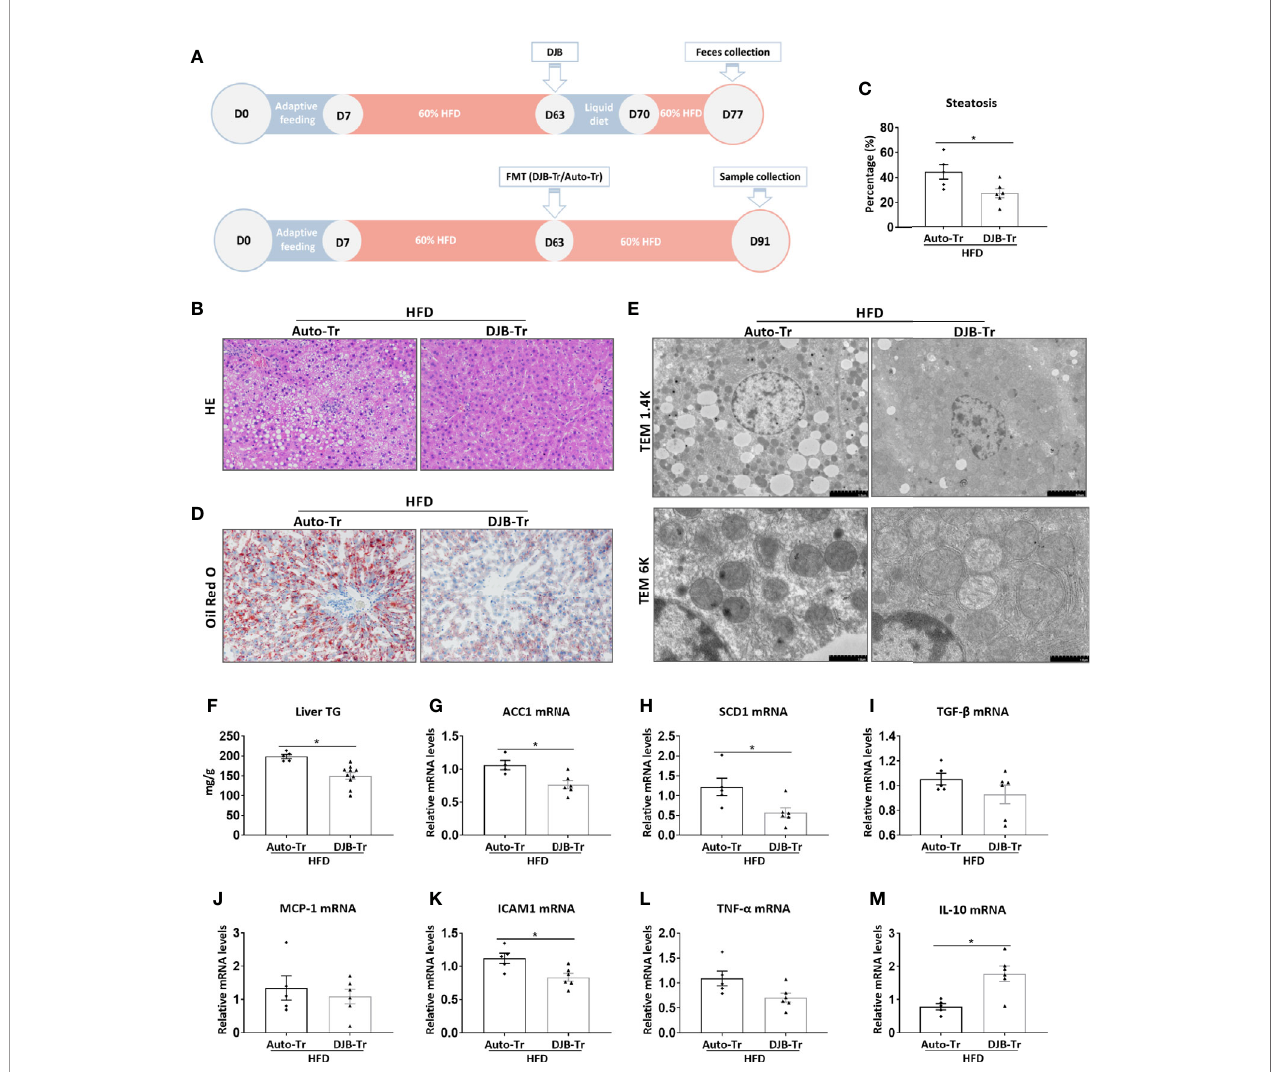
FIGURE 4 | Effects of FMT on hepatic steatosis in HFD-fed rats. (A) Feces were collected from HFD-DJB rats at 2 weeks after surgery. These feces were then transplanted to HFD-fed rats without DJB at 8 weeks after HFD feeding (HFD-DJB-Tr). The control rats received transplantation of their own feces (HFD-Auto-Tr). After fecal transplantation, the animals were maintained on the HFD for 4 more weeks. (B) Representative photomicrographs of liver histology from an HFD-fed rat receiving DJB FMT (HFD-DJB-Tr) and an HFD-fed rat receiving auto FMT (HFD-Auto-Tr). Original magni fi cation, x200. (C) the percentage of steatotic hepatocytes in HFD-DJB-Tr and HFD-Auto-Tr rats. Original magni fi cation, x200. (D) Representative photomicrographs of Oil Red O staining from aHFD-DJB-Tr rat and a HFD-Auto- Tr rat. Original magni fi cation, x200. (E) Representative images of electron microscopy from an HFD-DJB-Tr rat and an HFD-Auto-Tr rat. (F) Liver triglyceride content in HFD-DJB-Tr and HFD-Auto-Tr rats. Hepatic mRNA expression of ACC1 (G) , SCD1 (H) , TGF ‐ b (I) , MCP-1 (J) , ICAM1 (K) , TNF- a (L) , and IL-10 (M) in HFD-DJB- Tr and HFD-Auto-Tr rats. Results are expressed as mean ± SE (HFD-Auto-Tr, n=5; HFD-DJB-Tr, n=10) and compared by Student ’ s t-test; *p < 0.05 versus the HFD-Auto-Tr group. DJB, Duodenal-jejunal bypass surgery; HFD, High fat diet; NAS, NAFLD activity score; ACC1, Acetyl-CoA carboxylase-1; SCD1, Stearoyl-CoA desaturase-1; TGF ‐ b , Transforming growth factor beta; MCP-1, Monocyte chemotactic protein 1; ICAM1, Intercellular adhesion molecule 1; TNF- a , Tumor necrosis factor alpha; IL-10,